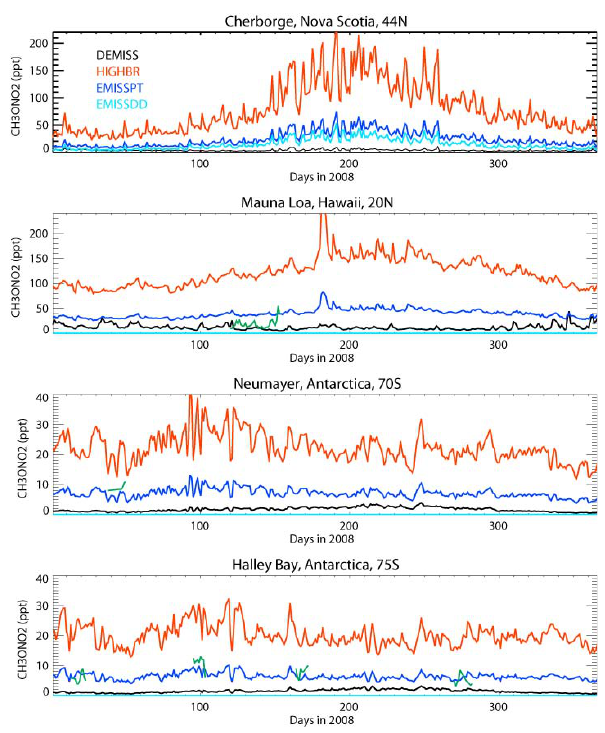
Fig. 5. Daily mean mixing ratios of CH 3 ONO 2 in the DEMISS, HIGHBR, FULL and DDEP simulations extracted at Chebogue (45 ◦ N, top), Mauna Loa (20 ◦ N, upper middle), Neumayer (70 ◦ S, lower middle) and Halley Bay (75 ◦ S, bottom). Where available, the observed mixing ratios of CH 3 ONO 2 are shown in green (see text for details). The simulations shown are EMISS (black), HIGHBR (red), FULL (dark blue) and DDEP